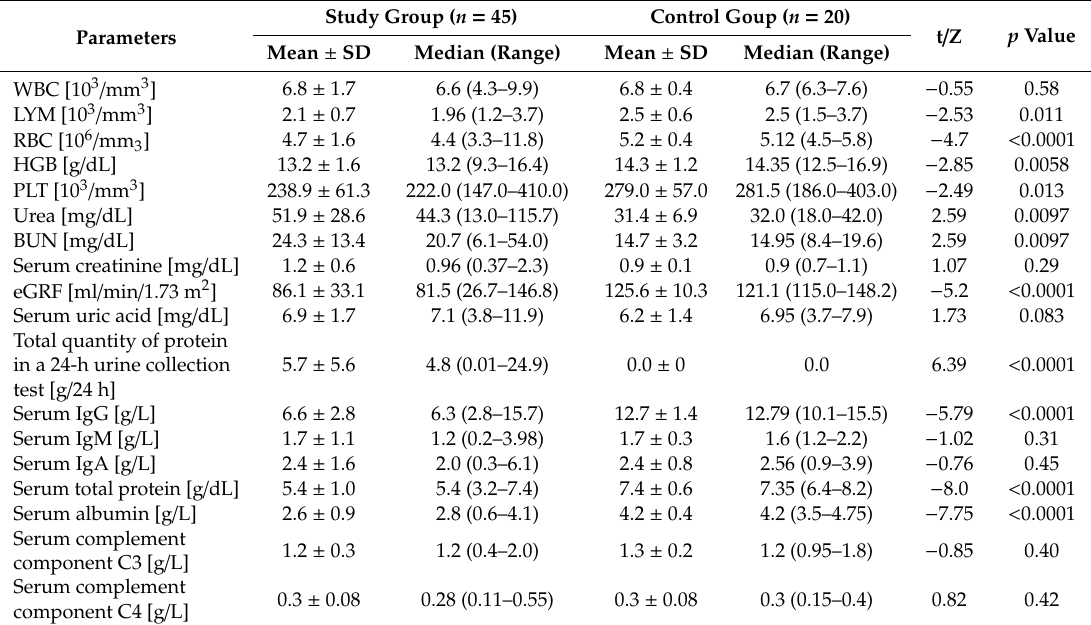
Table 1. Results of the complete blood counts, kidney function parameters, proteinograms, and complement components in patients and healthy controls.